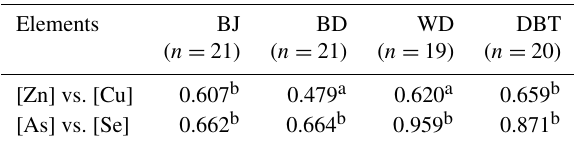
Table 5. The correlations between [Zn] vs. [Cu] and [As] vs. [Se] in PM 2 . 5 at the four sampling sites during the sampling period in the winter of